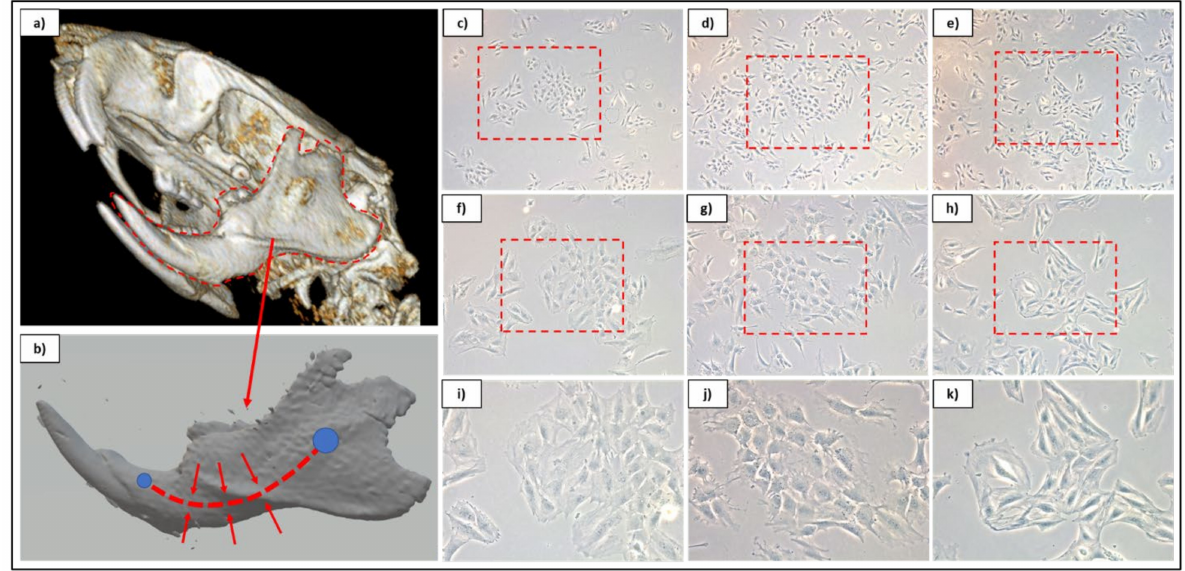
Figure 1. Overview graphic for dental pulp site on CT rendering ( a ) and reconstructed mandibular 3D model ( b ). Cultured cell isolates from α MEM-cultured cells from both enzymatic ( c , f , i ) and tissue outgrowth ( d , g , j ) methods and DMEM/F12- cultured cells using tissue outgrowth method ( e , h , k ). Phase contrast culture images are displayed at 5 × ( c–e ), 10 × ( f – h ), and 20 × ( i – k )